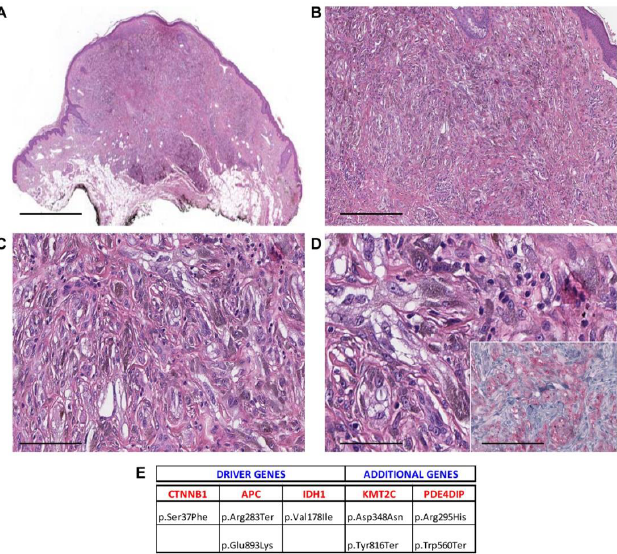
Figure 4. Case 16—male, 46 years old, right ear. ( A ) Asymmetric pigmented melanocytic tumor involving the dermis and subcutis and showing an expansile bulbous pattern at the base (40×, scale bar 500 µm); ( B ) the tumor is highly cellular and is composed of pigmented cells in plexiform pattern (100×, scale bar 100 µm); ( C ) several melanophages are seen within the melanocytic proliferation (200×, scale bar 50 µm); ( D ) melanocytes show a dusty-appearing pigmented cytoplasm and show enlarged nuclei (400×, scale bar 25 µm). Inset: Tumor cells show β-catenin expression at nuclear level (400×, scale bar 25 µm). ( E ) Mutational profile: driver gene mutations and additional pathogenic alterations .